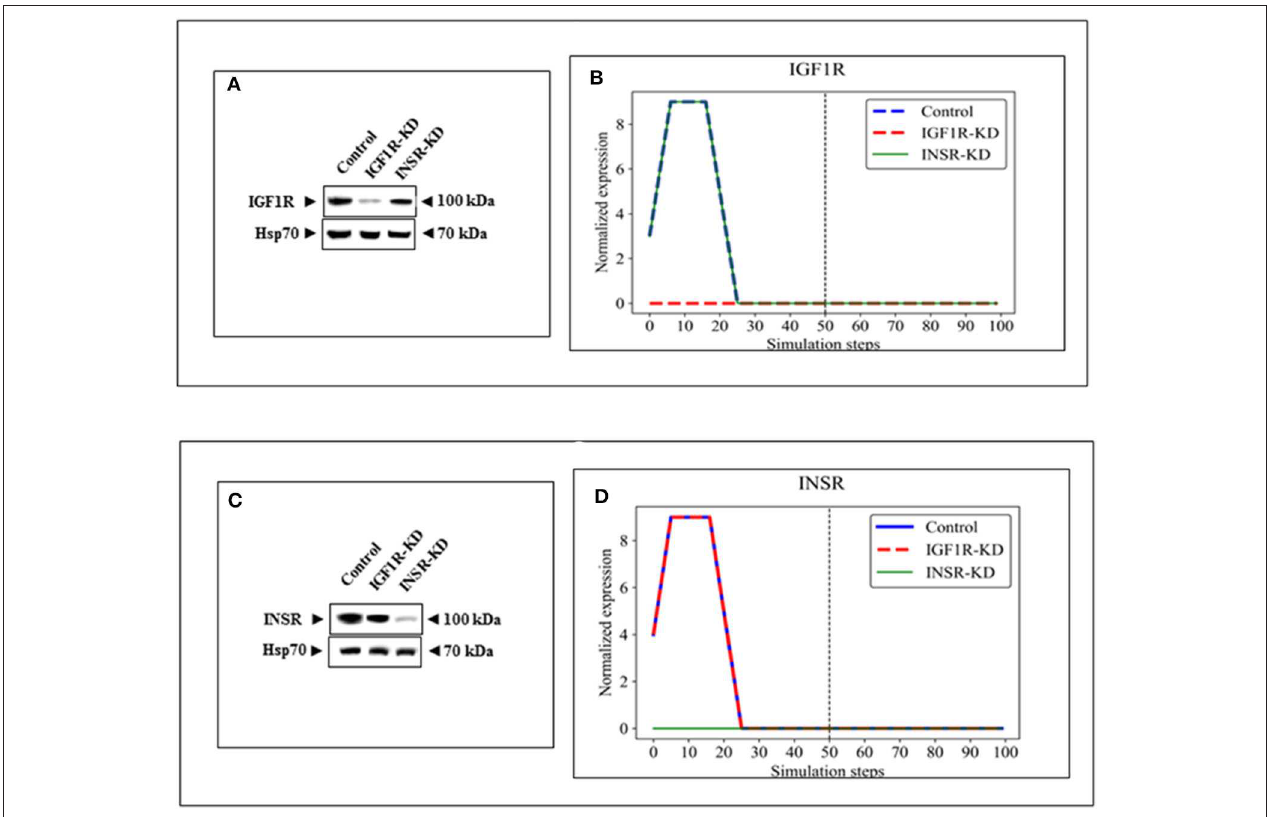
FIGURE 3 | Western blots and BioNSi simulation analyses of IGF1R and INSR expression after KD. Western blots of IGF1R (A) and INSR (C) were conducted using total lysates of Control, IGF1R-KD and INSR-KD cells. One-hundred simulation steps were performed as described in Figure 2 . A dashed vertical line indicates 50 steps of simulation. BioNSi plots of expression values against simulation steps are shown (B,D) . Control (blue), IGF1R-KD (red), and INSR-KD (green). Splicing has occurred in the blot figures and full scans of the entire original (unprocessed) gels are presented in Supplementary Material . Squares in the uncropped films denote bands shown in the final